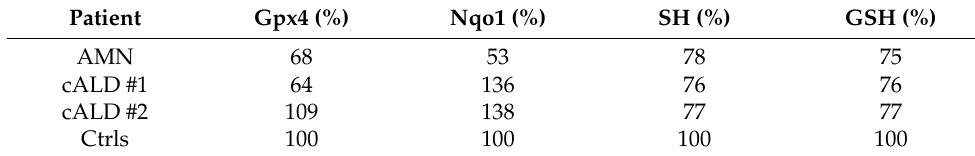
Table 3. Enzyme activities and glutathione levels expressed as percentage respect to Ctrls.